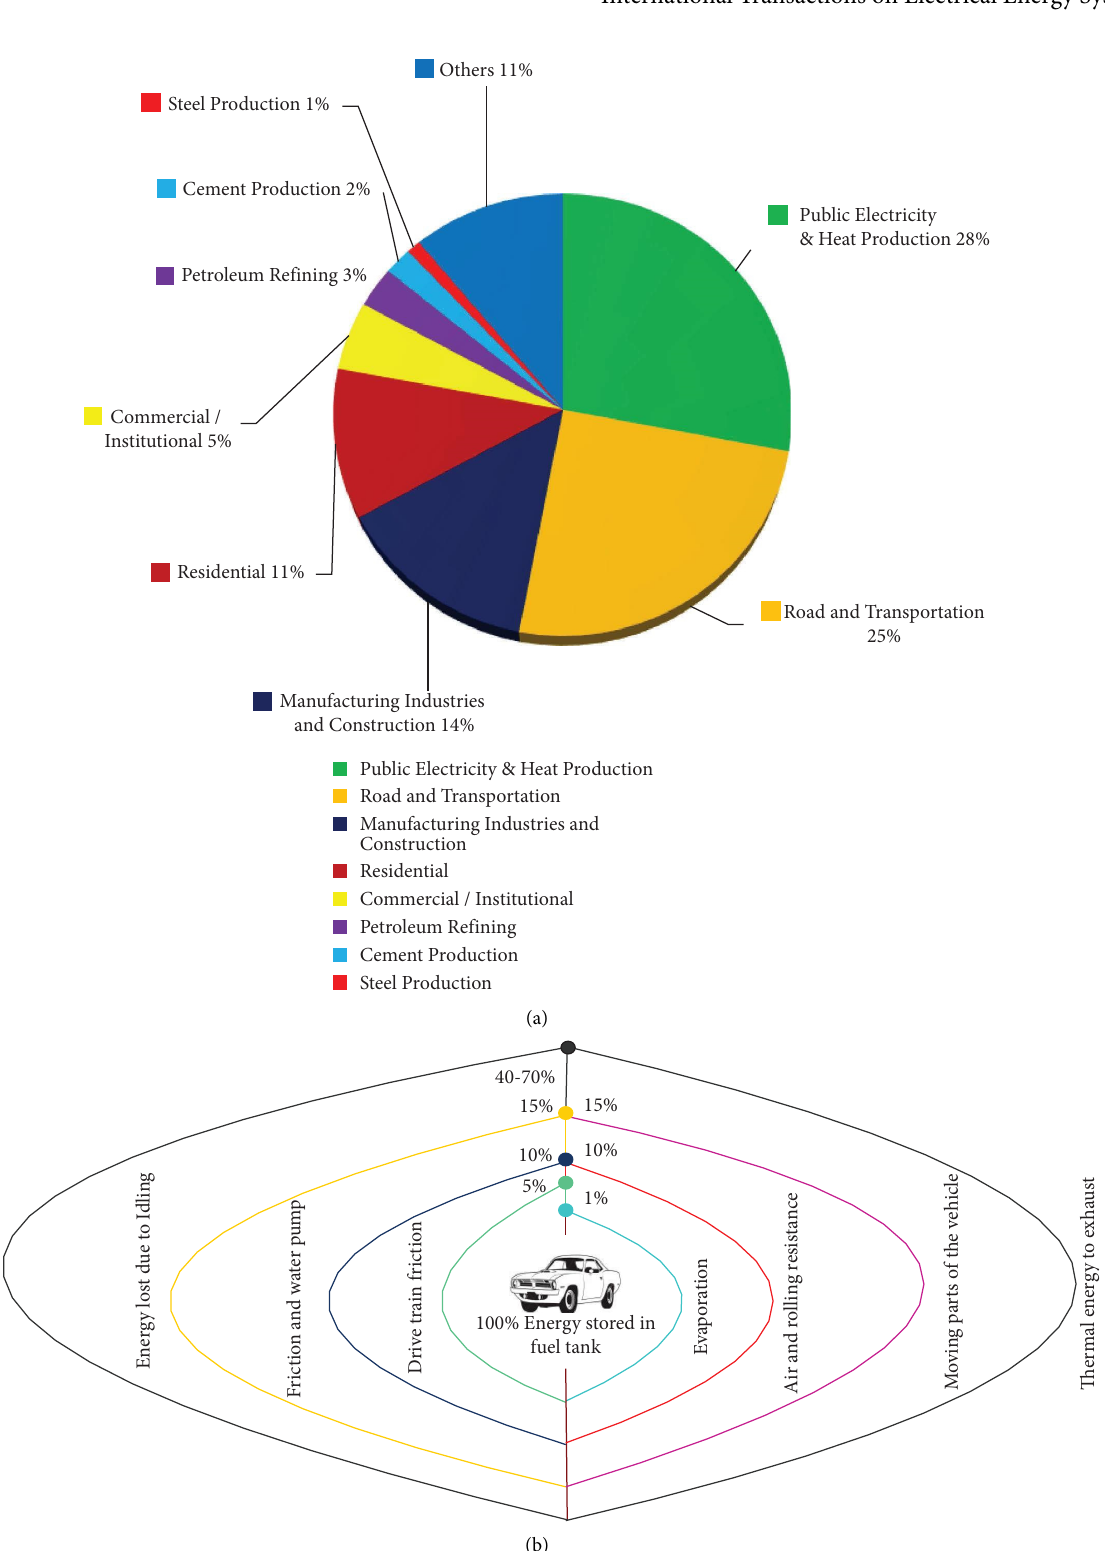
Figure 1: (a) Greenhouse gas emissions sector according to the European environmental agency (EEA) inventory report 2019 [3]. (b) Energy fow diagram of an internal combustion engine